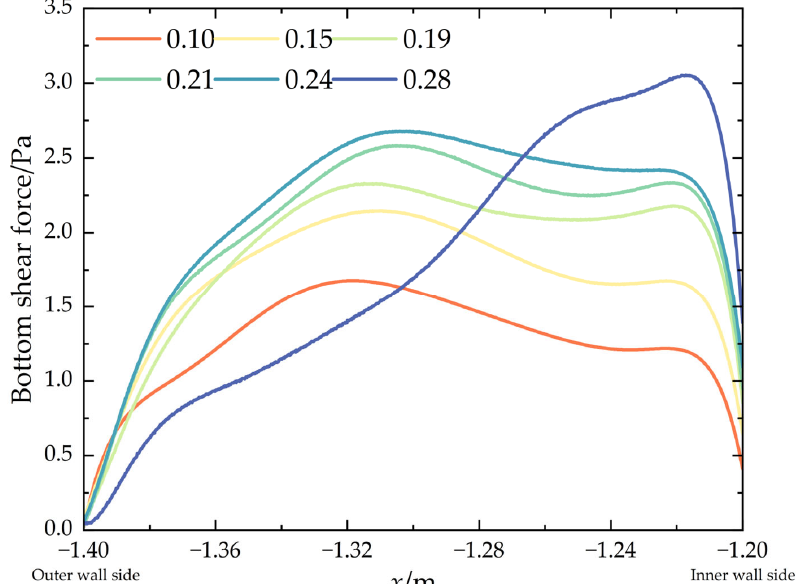
Figure 7. Distribution of shear force at the bottom of the flume at different speed ratios, where x is the distance from the center of the circle.